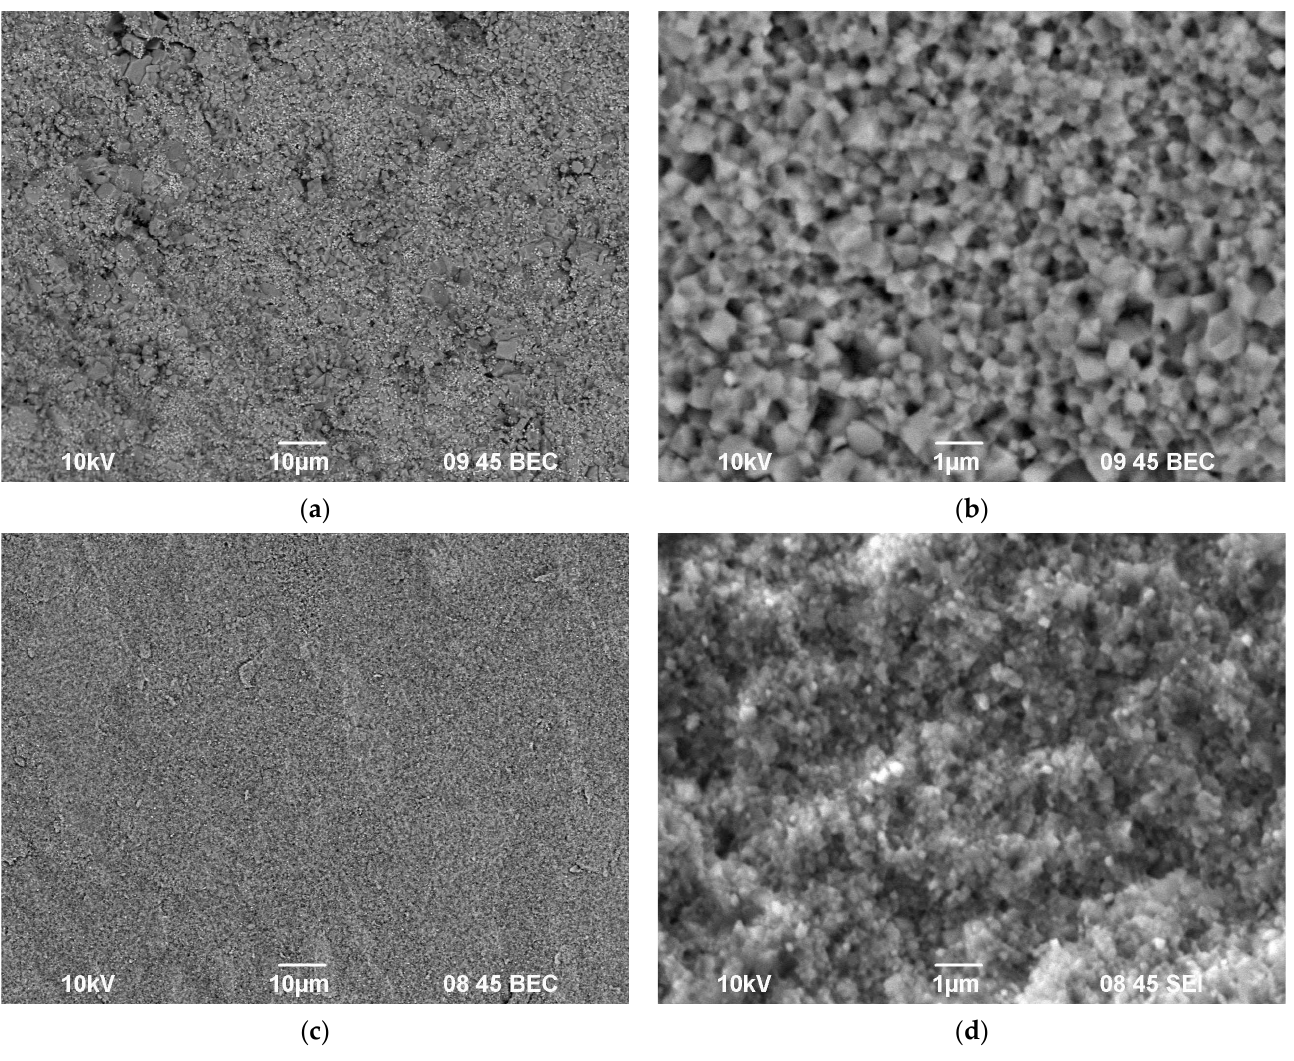
Figure 16 . Microstructure of Na 1-x Zr 2 (PO 4 ) 3-x (MoO 4 ) x ceramics with x = 0.1 ( a , b ) and x = 0.5 ( c , d ). SEM images of the fractures of sintered ceramic samples ( b , d ).